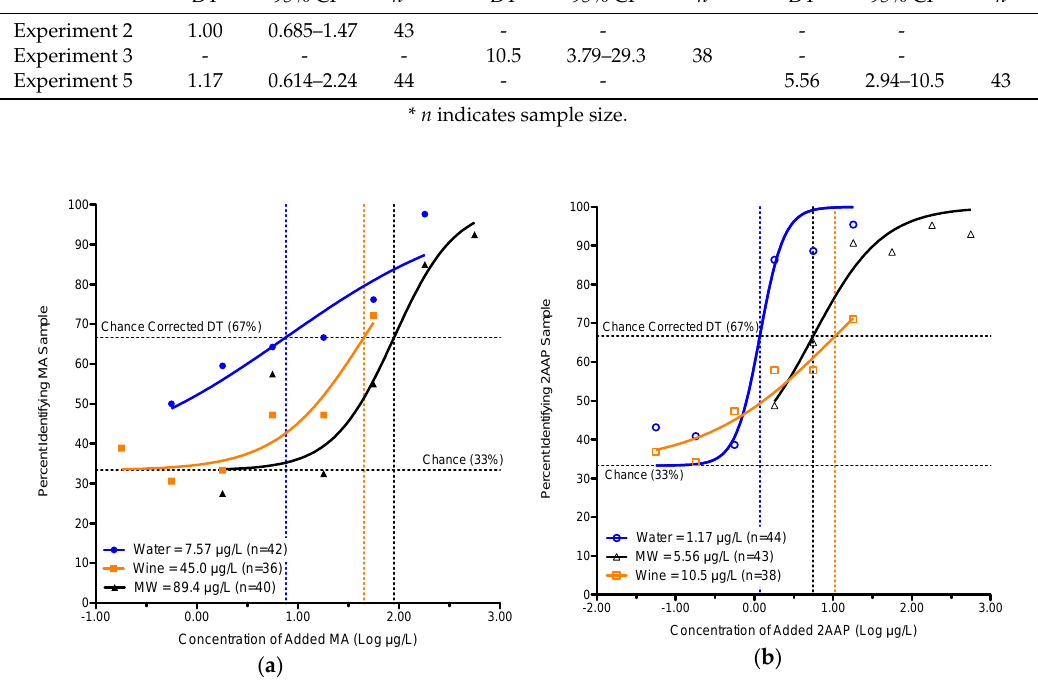
Table 3. Detection Thresholds ( µ g/L) for 2-aminoacetophenone.